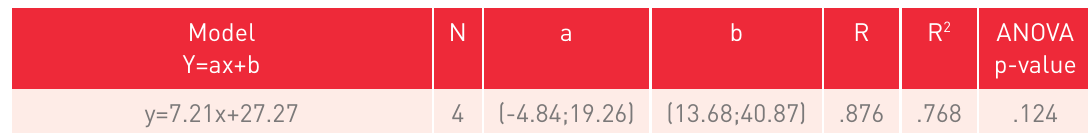
Table 7. Result of linear regression analysis Model